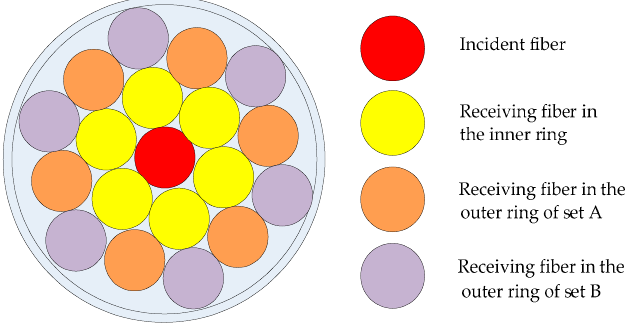
Figure 2. The double-circle-coaxial (DCC) fiber probe schematic diagram.